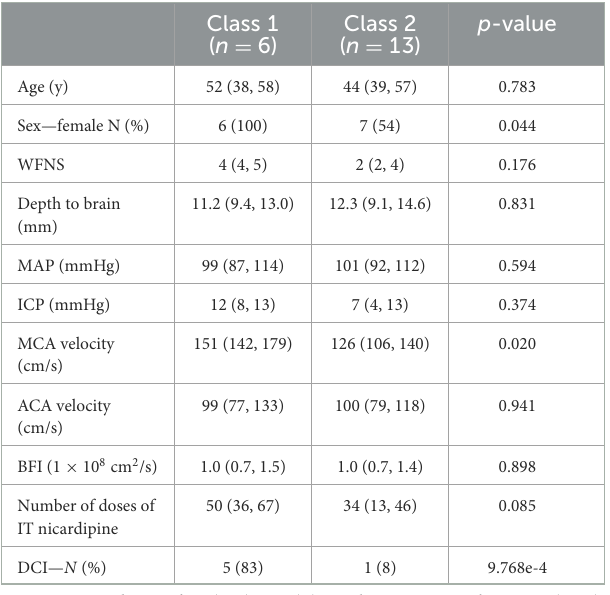
TABLE 3 Summary of patient differences between cerebral blood flow response classes.